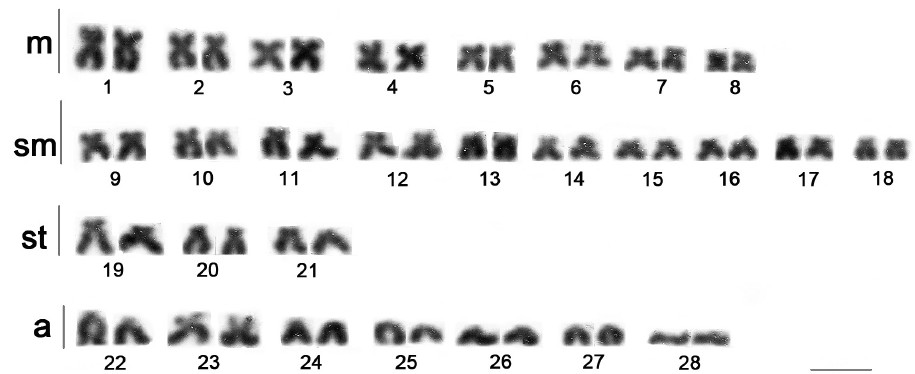
Figure 1. Karyotype of Phractocephalus hemioliopterus. Conventional Giemsa staining. Scale bar: 5 µm.